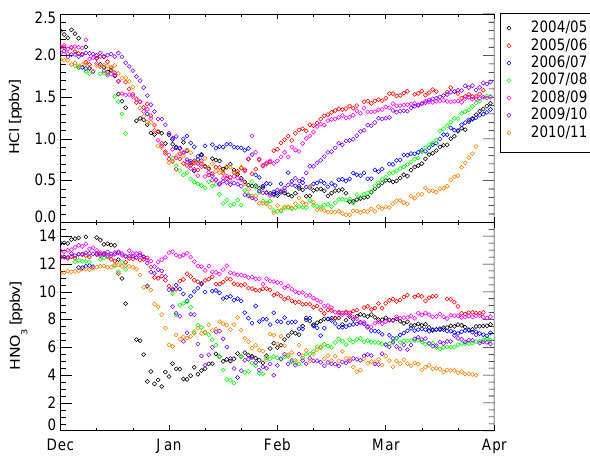
Fig. 6. HCl and HNO 3 observations by MLS for the Arctic win- ters 2004/2005 to 2010/2011 on 500 K potential temperature in the vortex core (equivalent latitude > 75 ◦ N).